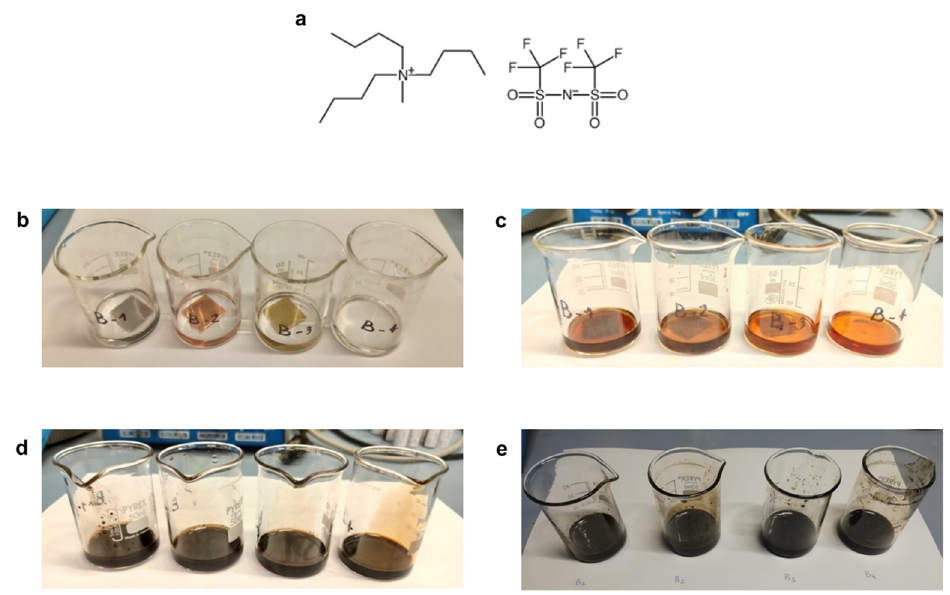
Figure 1. ( a ) Structure of the ionic liquid [TBuMA][NTF 2 ]. ( b ) In sequence, from left to right, samples of the ionic liquid in the presence of steel, copper and brass metal plates and with no metal plate. The same samples were heated at 200 °C for 4 h ( c ), 24 h ( d ) and 168 h ( e ).